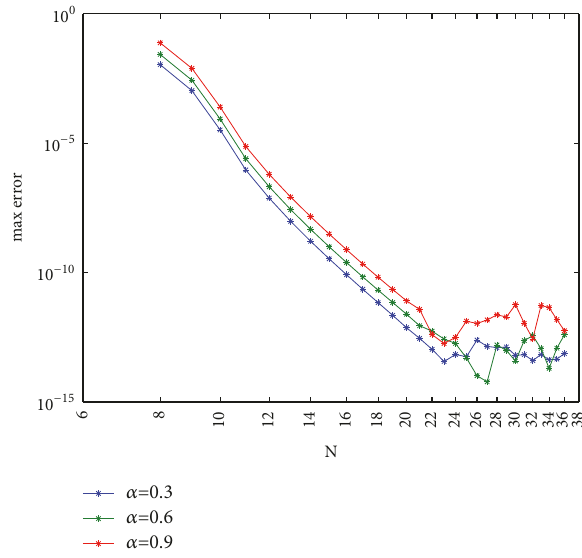
Figure 4: Log-log plot of the maximum error for 𝑟 = 6 .